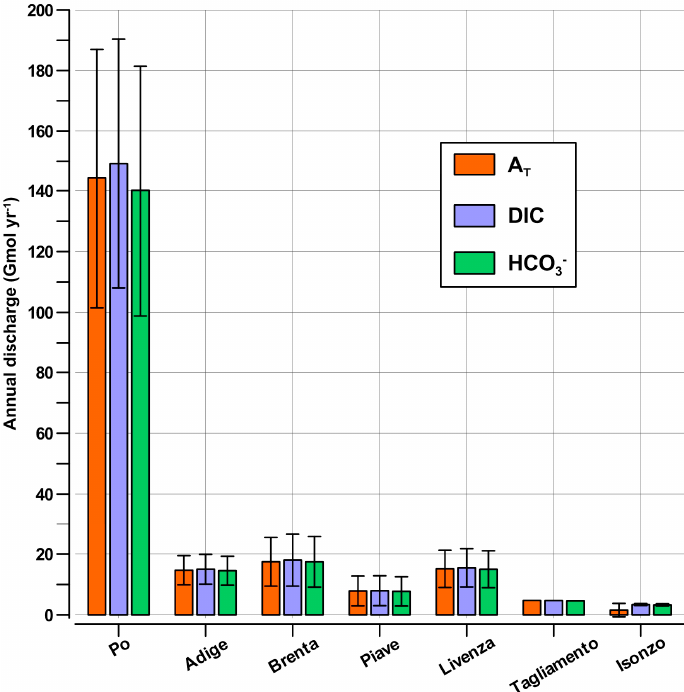
Figure 8. Mean annual transport of A T , DIC and HCO 3 − (Gmol yr − 1 ) from the NAd rivers. Data for the Tagliamento and Isonzo rivers were estimated for 2007 and 2011 only.